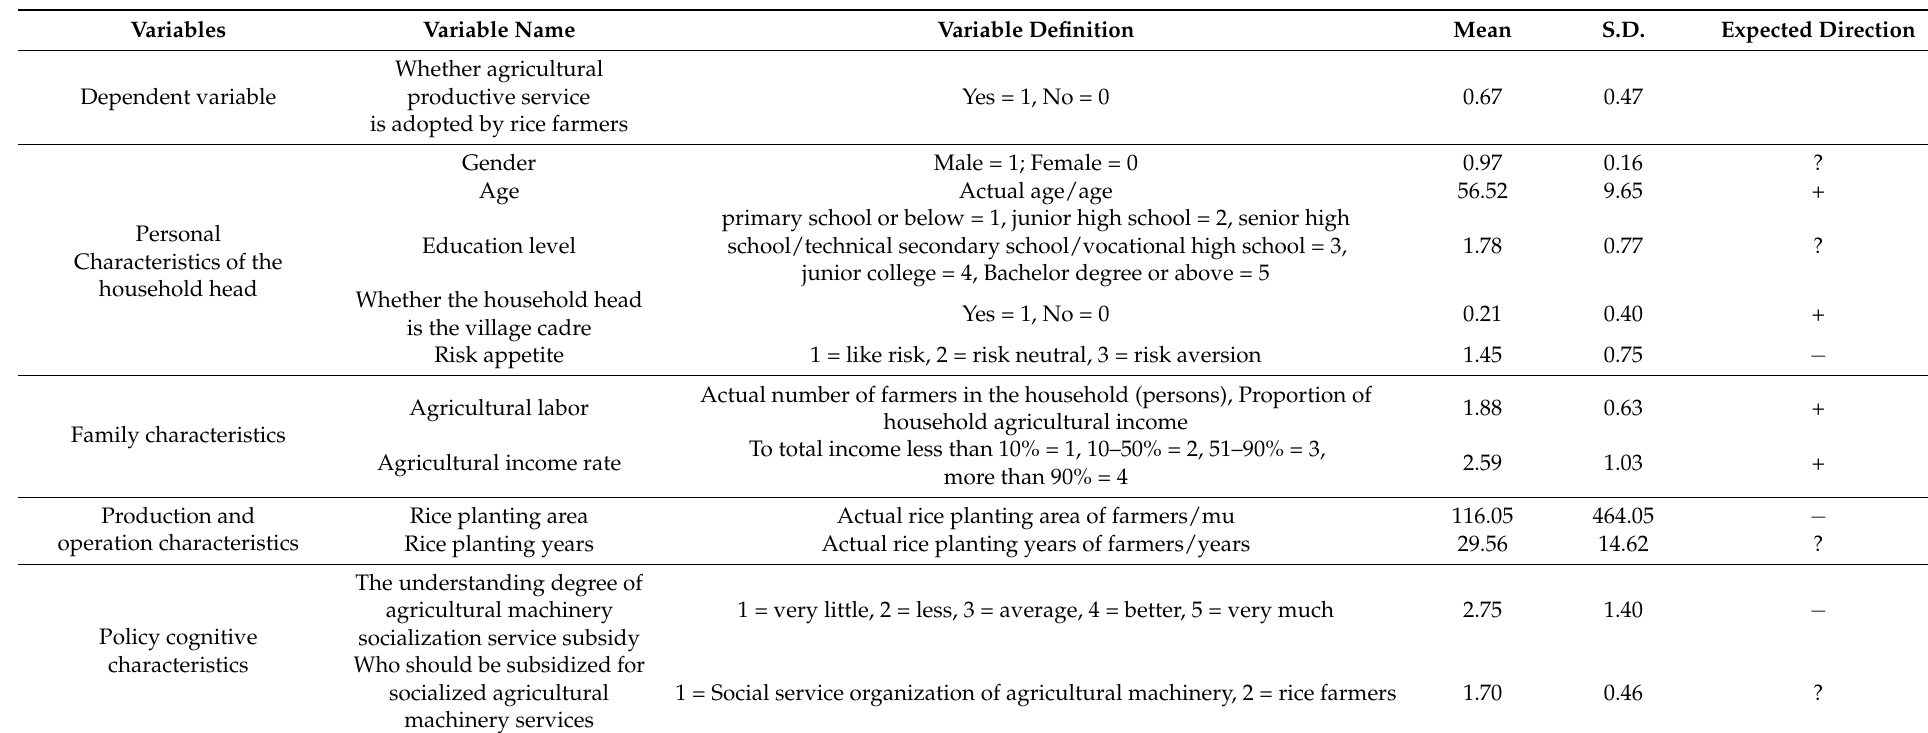
Table 1. Variable description and descriptive